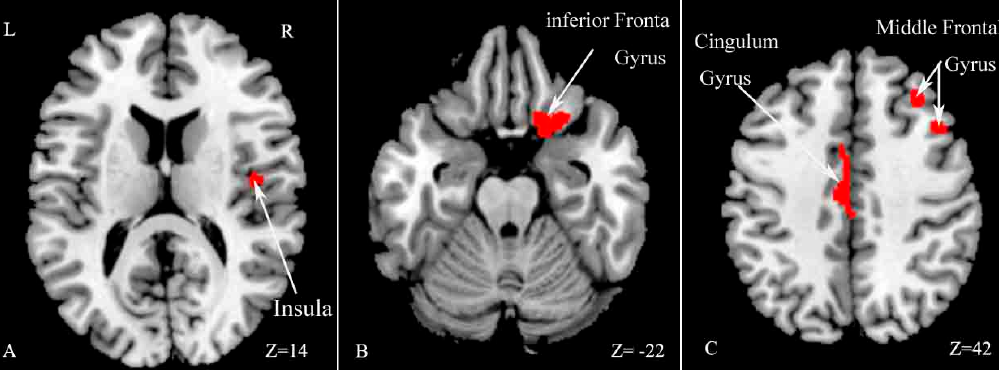
Table 2. The decreased volumes of gray matter (GM) in MS patients compared to HCs ( p FWE correction < 0.05). Brain Region Number of Voxels (mm 3 ) Right insula Right inferior frontal gyrus Right middle frontal gyrus 268 Left cingulate gyrus Each cluster represents the extension where local maxima are located, along with the MNI coordinates, and the T values of the most significant voxel are reported. A threshold of p < 0.05 is set for the data, and the data are corrected using the false discovery rate (FDR). MNI = Montreal Neurological Institute; FWE = family-wise error.